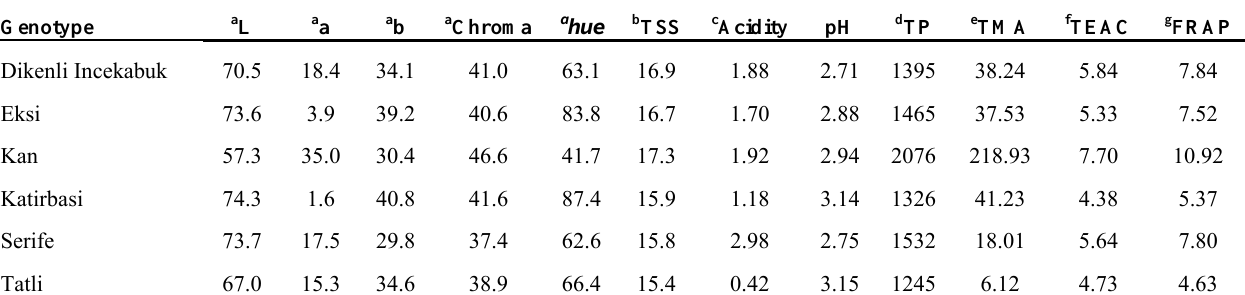
Table 1 . Pomological and phytonutrient characteristics of the pomegranate cultivars studied. Data adapted from a previous study by Ozgen et al . [1].